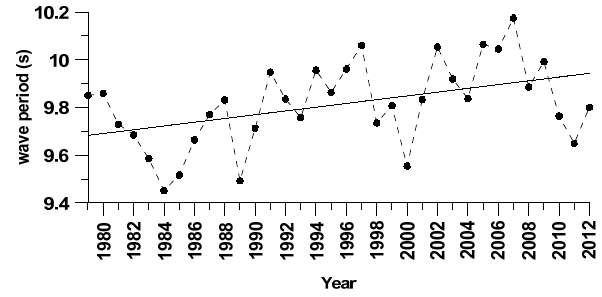
Figure 9. Variation of annual 90 th percentile energy wave period during 1979-2012